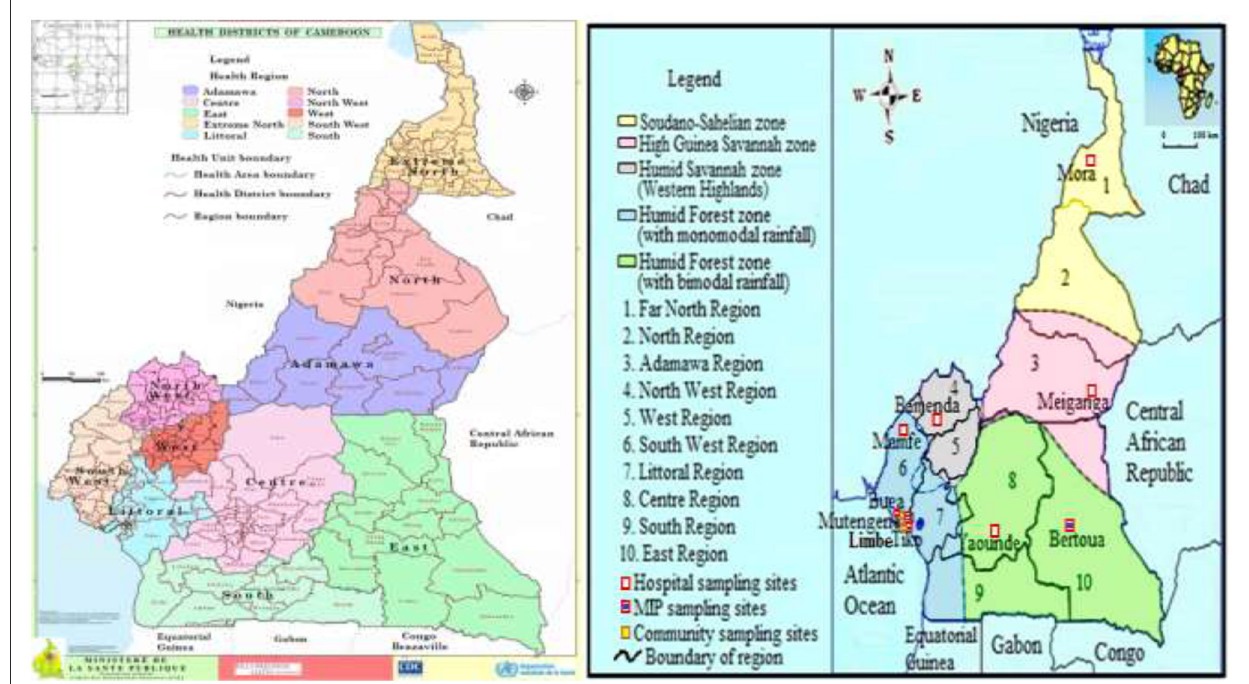
FIGURE1 Map of ecological and malaria transmission zones in Cameroon (21, 22), indicating community/hospital sampling sites and Health Districts. https:// dhis-minsante-cm.org/portal/index.html.